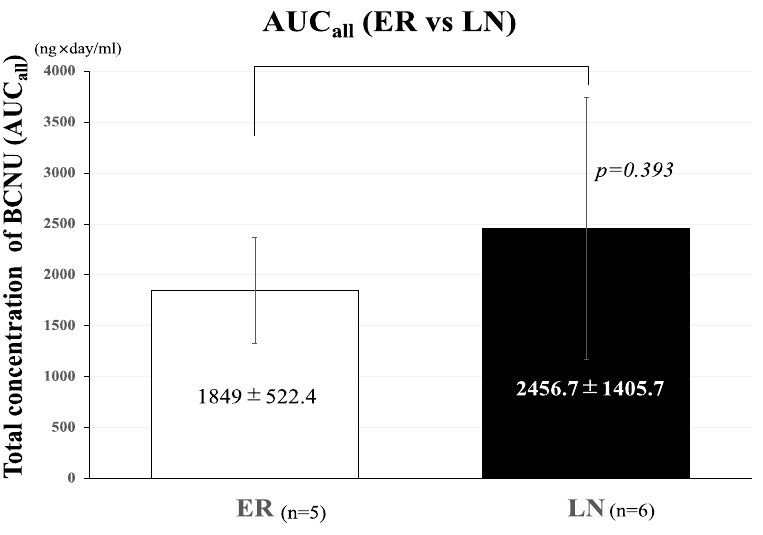
Figure 3. Effects of total concentration (AUC all ) of BCNU on the development of tumor recurrence. Bar graph showing the comparison of AUC all of BCNU between the ER and LN groups. The AUC all of BCNU concentrations in the ER group (1849 ± 552.4 ng · day/mL) was lower than that in the LN group (2456.7 ± 1405.7 ng · day/mL), but the difference was not statistically significant ( p = 0.393). The bar graph shown in a white color represent AUC all of ER and that in a black color represent AUC all of LN. Error bars represent standard deviation.